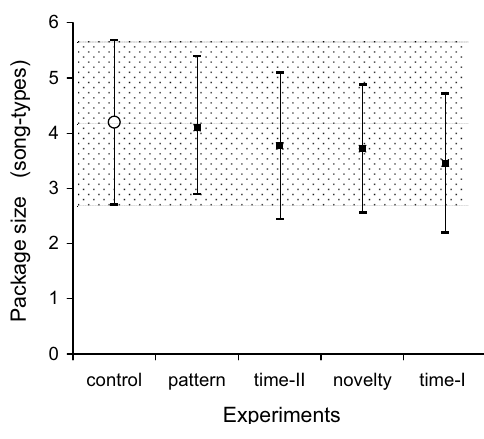
Fig. 8 – Mean ( ± SD ) size (given as number of song-types) of packages developed from the song strings to which subjects were exposed in this study. In addition, the respective measure pooled from control experiments (homogeneous string structure; n = 75 packages, see Hultsch and Todt 1989) is given for